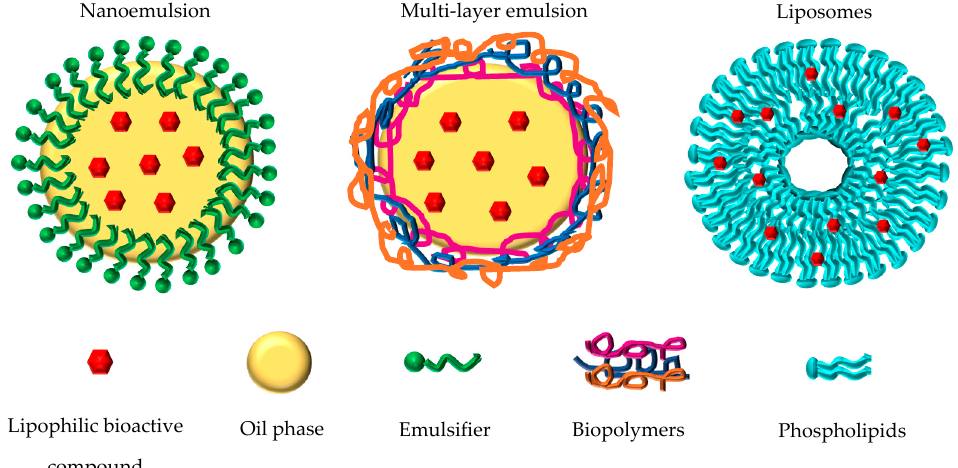
Figure 1. Nanostructured lipid-based delivery systems for encapsulating lipophilic bioactive compounds.